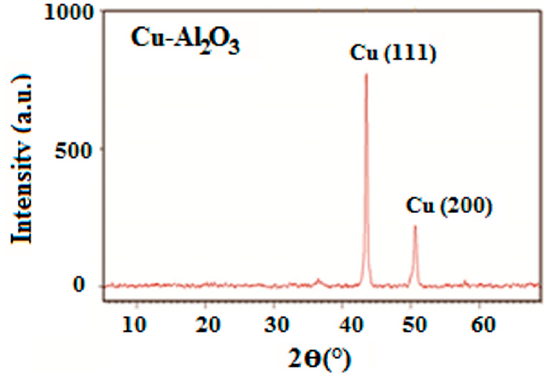
Figure 2. XRD pattern of Cu-coated Al 2 O 3 nanopowder.